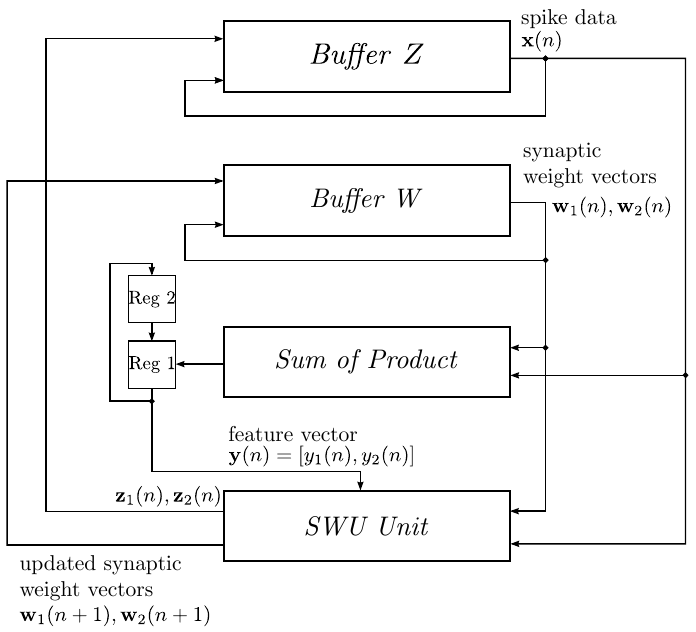
Figure 6. The architecture of the basic single-channel generalized Hebbian algorithm (GHA) circuit for feature extraction for p = 2 . The GHA circuit contains buffers, the sum of products (SOP) circuit and the synaptic weight vector updating (SWU) unit. The buffers store spike data and synaptic weight vectors. The SOP circuit computes feature vectors, and the SWU unit updates synaptic weight vectors. The SWU unit can be further separated into a number of modules.